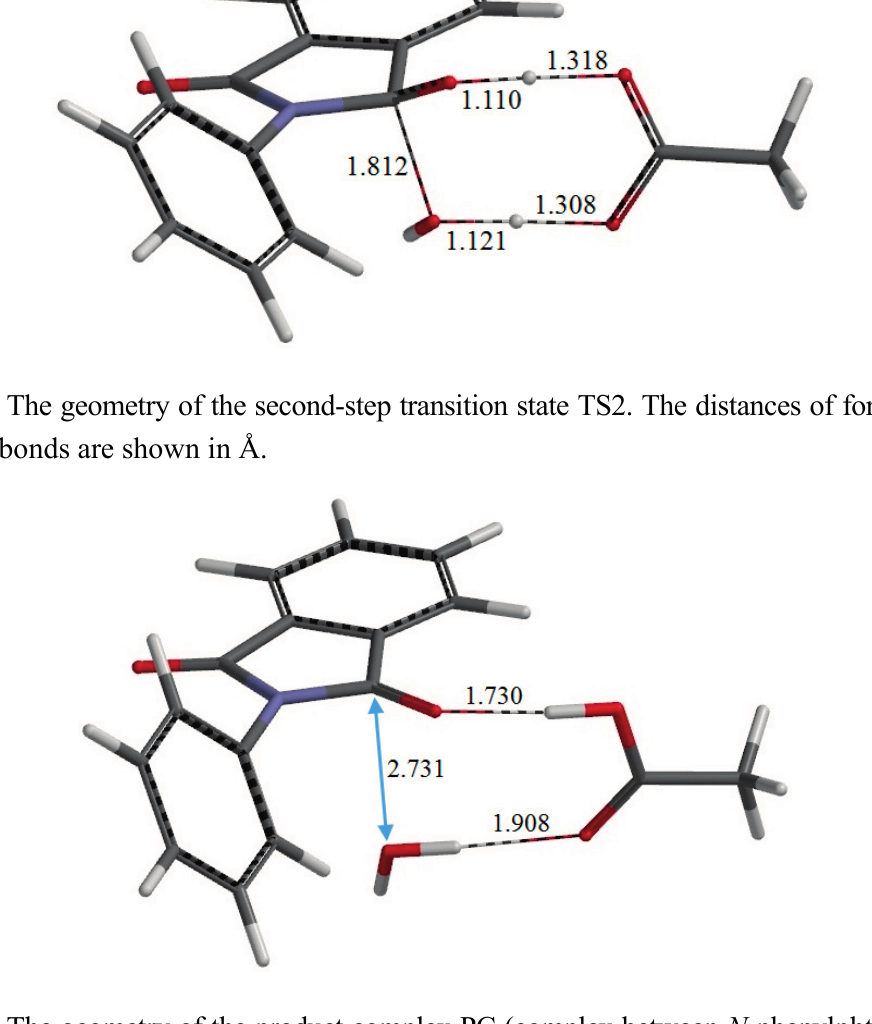
Figure 8. The geometry of the product complex PC (complex between N -phenylphthalimide, acetic acid, and water). Selected interatomic distances are shown in